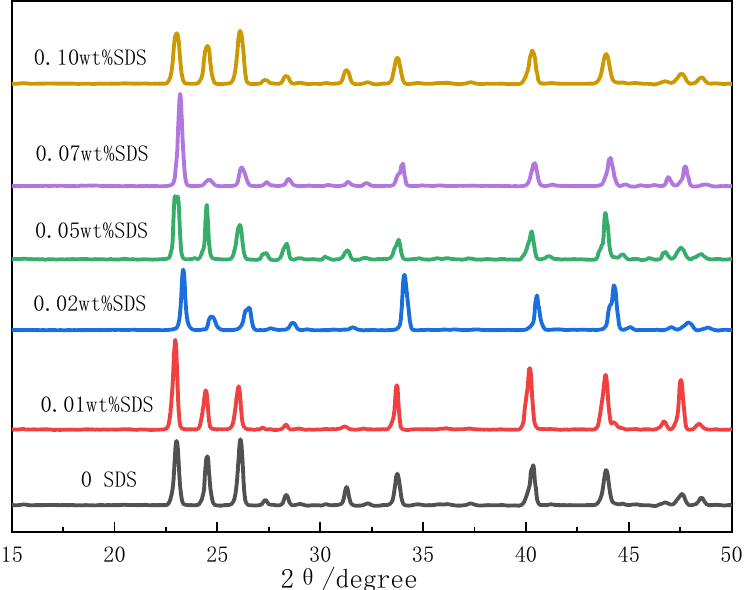
Figure 5. XRD patterns of CO 2 hydrate generated by 3.5 wt.% NaCl + SDS solution.